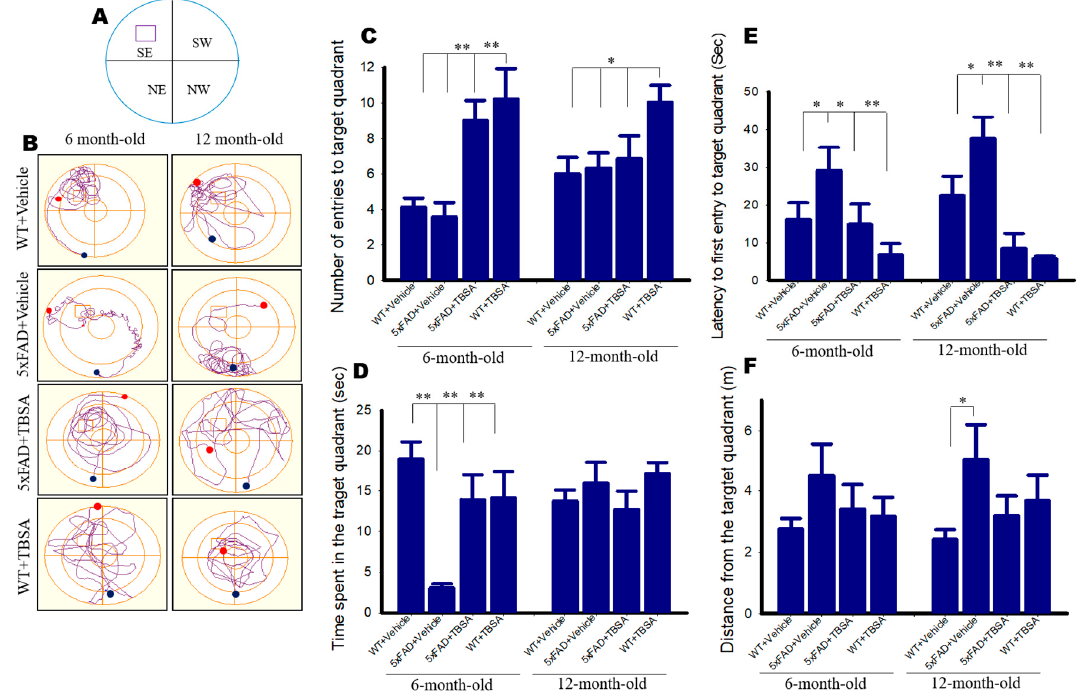
Figure 10. Treatments of trans-beta-styryl-boronic acid (TBSA) prevented deficits in spatial memory during the probe trial in the Morris-water-maze task. After 5 days of training in the MWM, all groups of mice were given a 60-s probe trial and the latency to first entry, time spent, mean number of entries, and mean distance from the target quadrant were measured. ( A ): Graphical representation of MWM tank and di ff erent quadrants, along with location of platform. ( B ): Representative swim paths of each treatment group during the probe trial, with blue and red dots marking the starting and end points, respectively. ( C ): The mean number of entries into the target quadrant was significantly di ff erent in 5xFAD + TBSA and WT + TBSA in comparison to 5xFAD + vehicle and WT + vehicle-treated groups. ( D ): Time spent in the target quadrant was decreased for the 6-, but not the 12-month-old 5xFAD mice, and this deficit was mitigated by the TBSA treatment. ( E ): There was an increase in latency of first entry to the target quadrant for vehicle-treated 5xFAD mice, whereas TBSA treatment prevented this increase. ( F ): The 12-month old 5xFAD mice had an increase in mean distance from the platform location, which was prevented in the TBSA-treated mice. Values are expressed as means ± SEM. * p < 0.05 and ** p < 0.01 in comparison to WT + Vehicle, 5xFAD + TBSA and WT + TBSA.